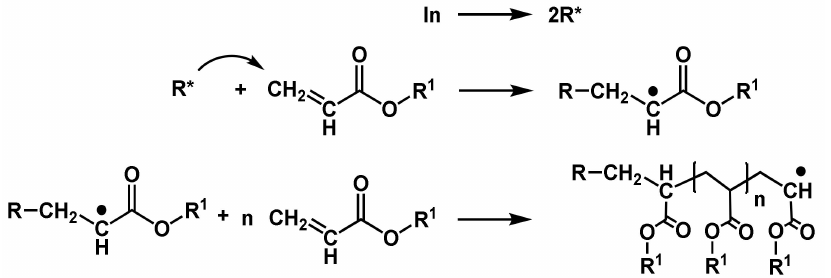
Figure 11. Schematic representation of the radical polymerization reaction of acrylates. In represent- ing the initiator and R* the radical.